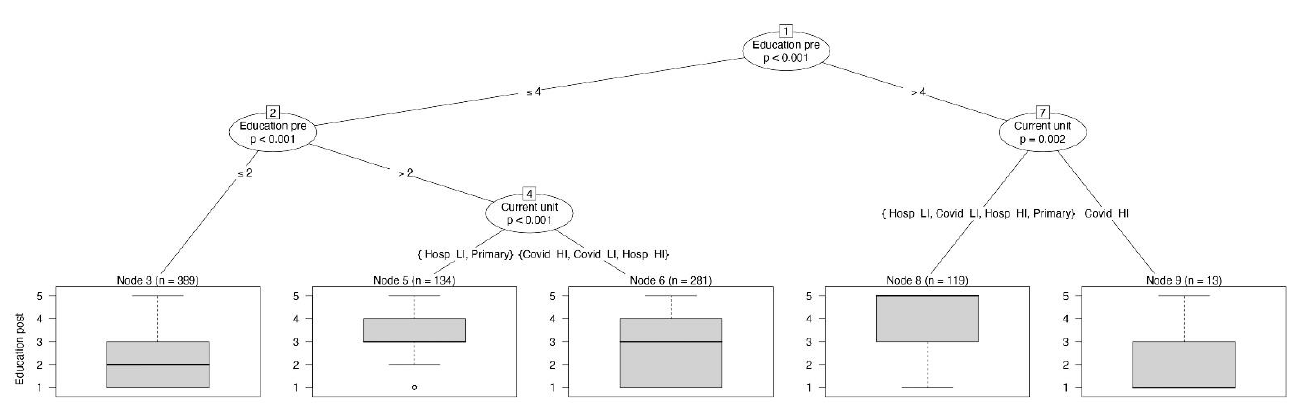
Figure 3. The conditional inference tree with the frequency of patient education as dependent variable, reported at the bottom of the figure as boxplot.